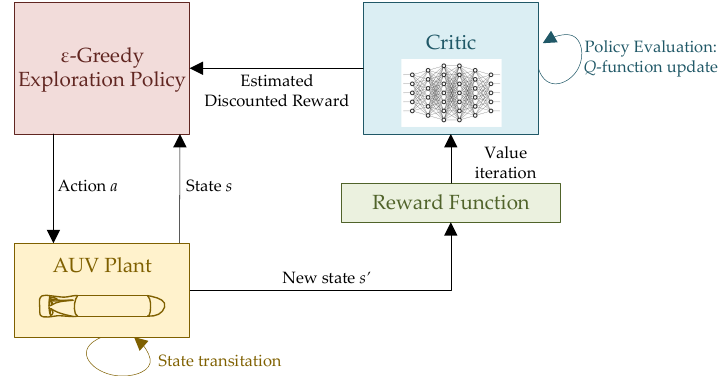
Figure 4. Diagram of the DQN algorithm for the docking control of an